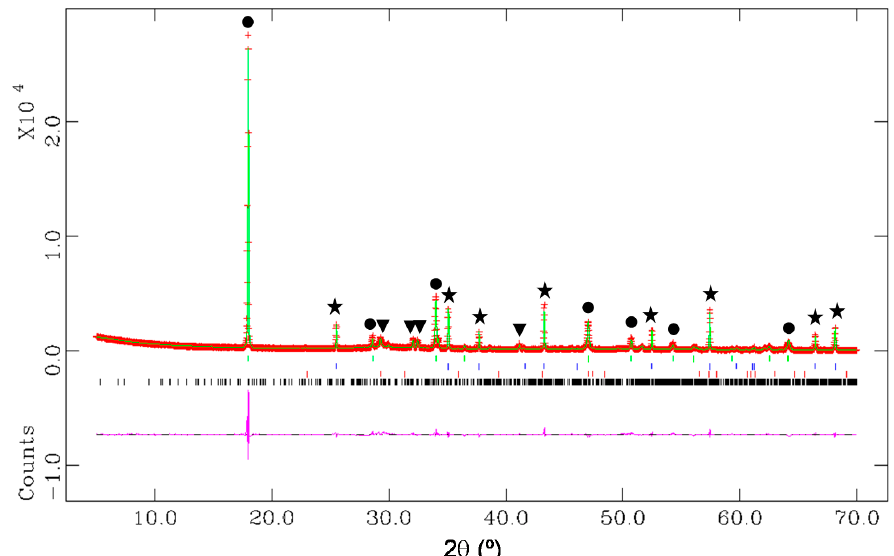
Figure 1. Laboratory X-ray powder diffraction (LXRPD) Rietveld plot (CuK α 1 radiation, λ = 1.54059 Å) with internal standard for the alite w/s = 0.80 paste hydrated for 34 days. The crystalline phases are portlandite (high content, ICSD #202220) and alite (ICSD #94742) and calcite (low contents, ICSD #80869). The main peaks are labelled as follows: portlandite ( • ), alite ( (cid:72) ) and added internal standard, α -Al 2 O 3 ( , ICSD #73725).